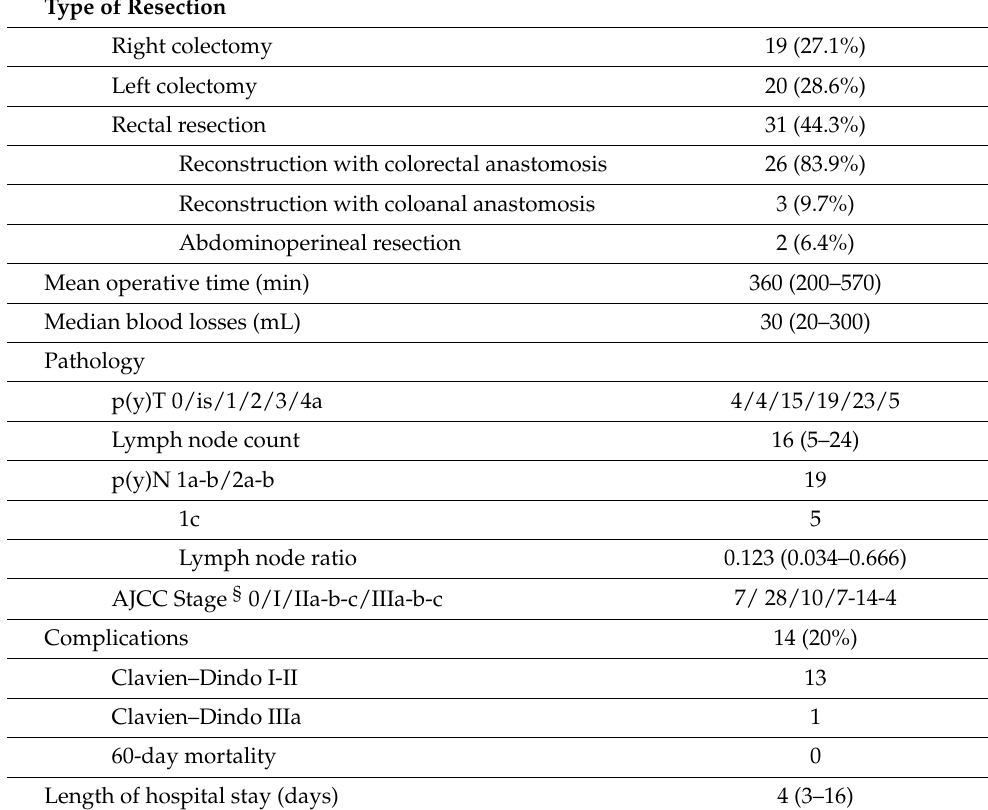
Table 2. Operative, pathology, and clinical outcome